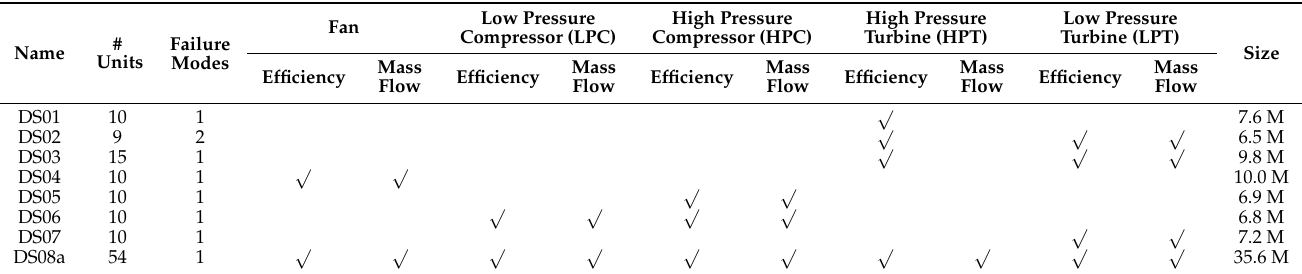
Table 1. N-CMAPSS database specifics and deterioration modes.